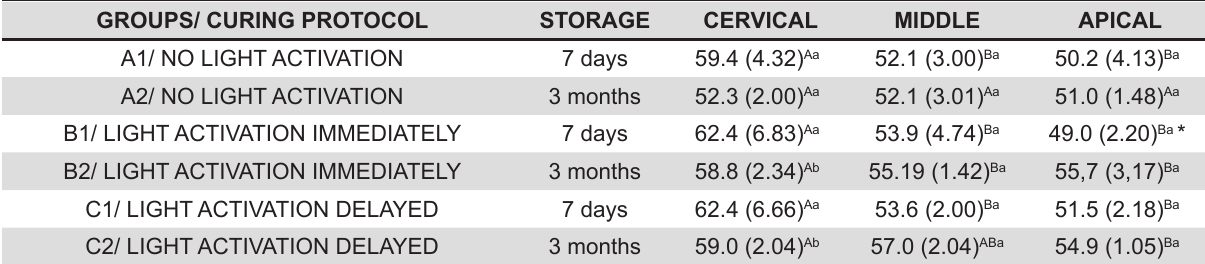
* indicates significant differences between storage periods for the same group (subgroups 1 and 2). Identical capital letters indicate no significant differences among thirds for the same curing protocol (p>.05). Identical lower cases indicate no significant differences among curing protocols within each third (p>.05).